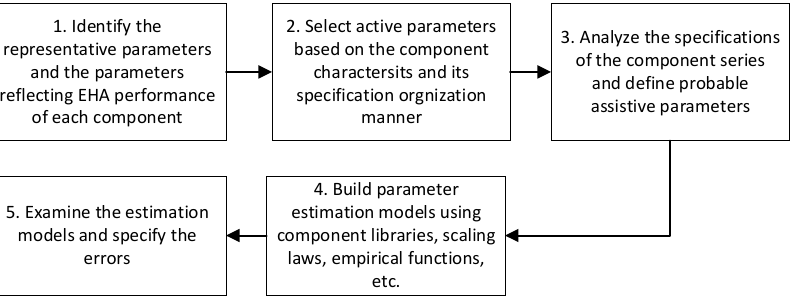
Figure 4. The classification and estimation procedures of the component parameters.